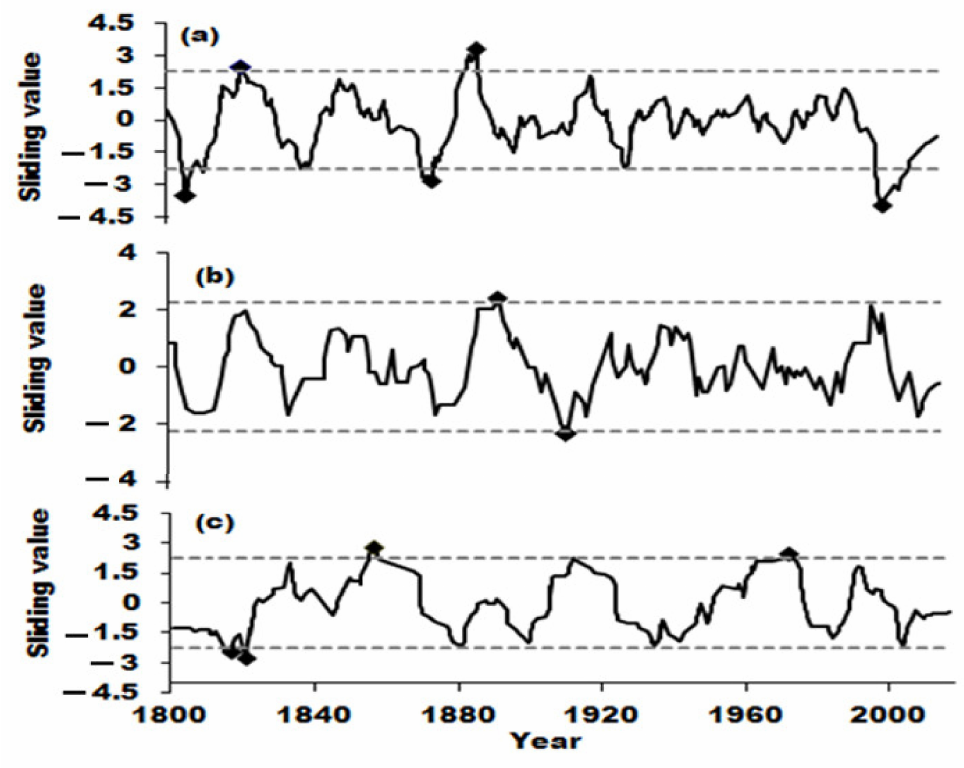
Figure 7. Sliding t-test for the mutations of droughts and floods during 1800–2017. ( a ): Year; ( b ): Summer; ( c ):